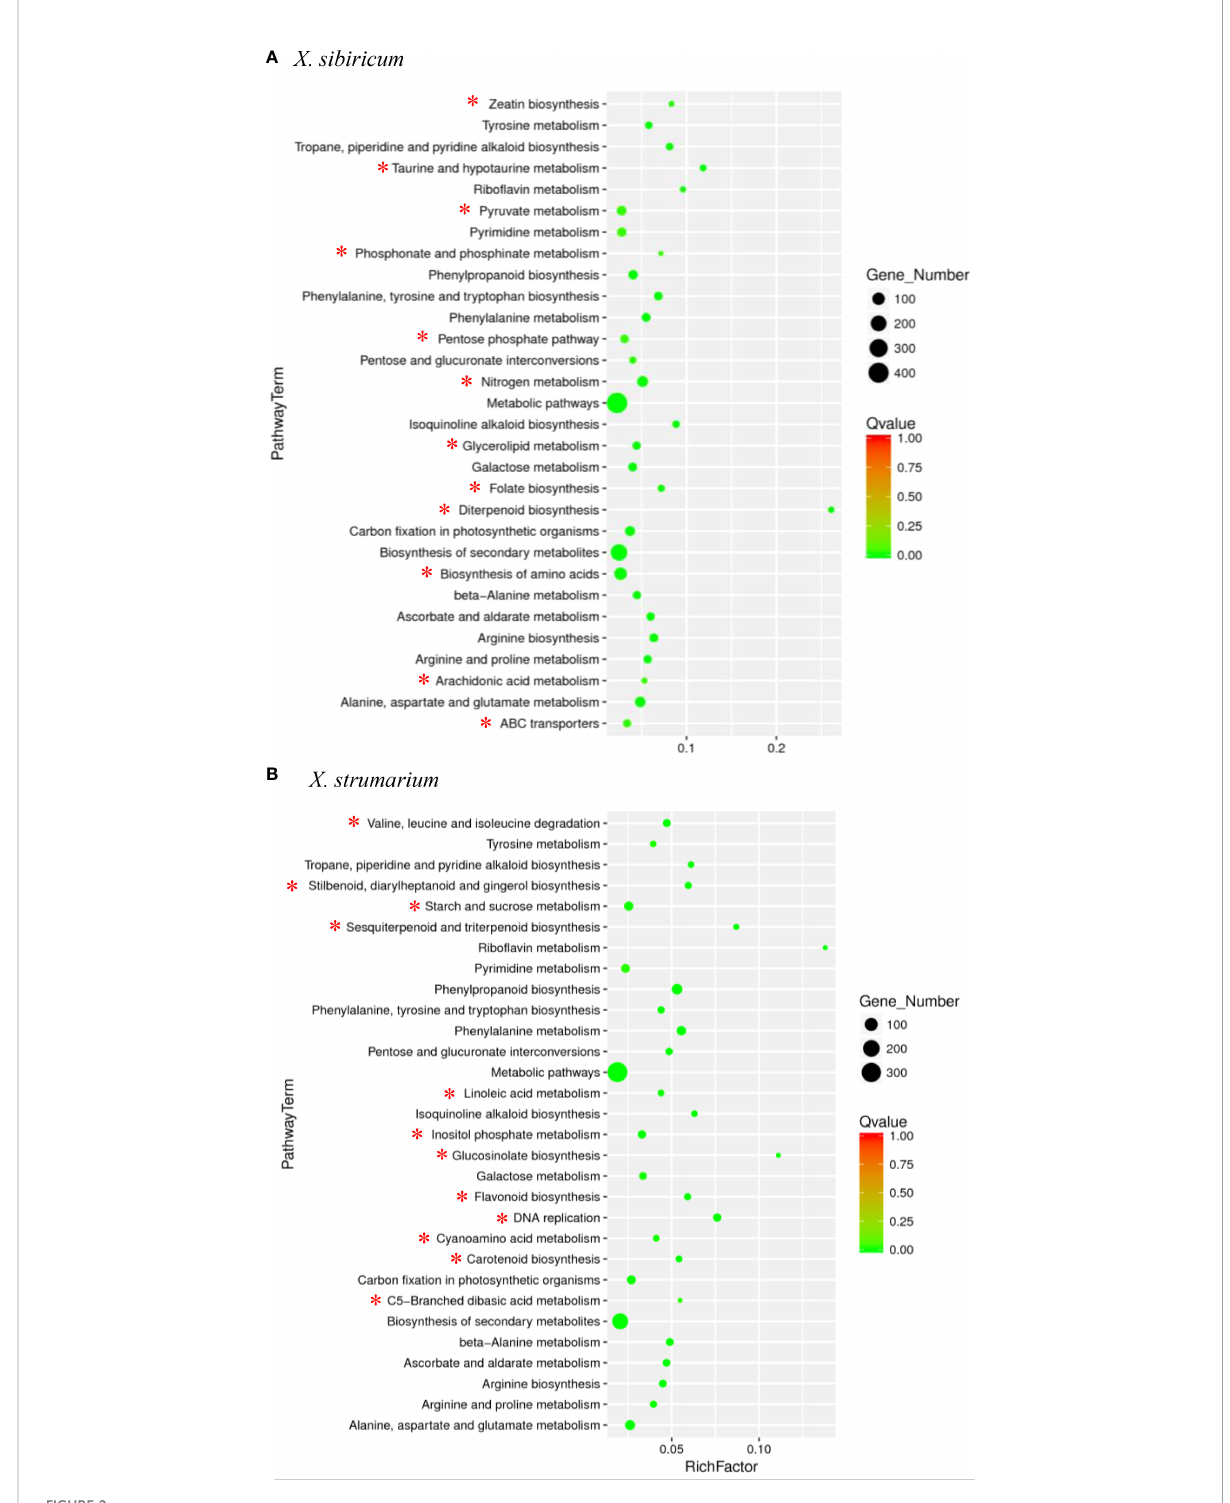
FIGURE 2 Pathways enrichment analysis for differently expressed transcripts (DETs) in Xanthium sibiricum (A) and X. strumarium (B) . Circle size indicates the number of DETs enriched in each pathway. Q value indicates signi fi cance of the enrichment, increasing from red to green. Rich factor represents the ratio of the enriched DETs to total transcripts in this pathway. The 12 unique pathways for each species are marked with *, and the 18 common pathways are